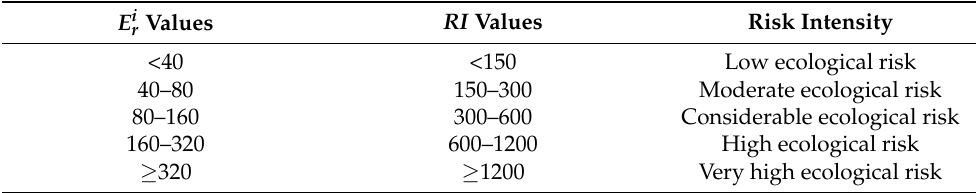
Table 2. Classification criteria of potential ecological risk